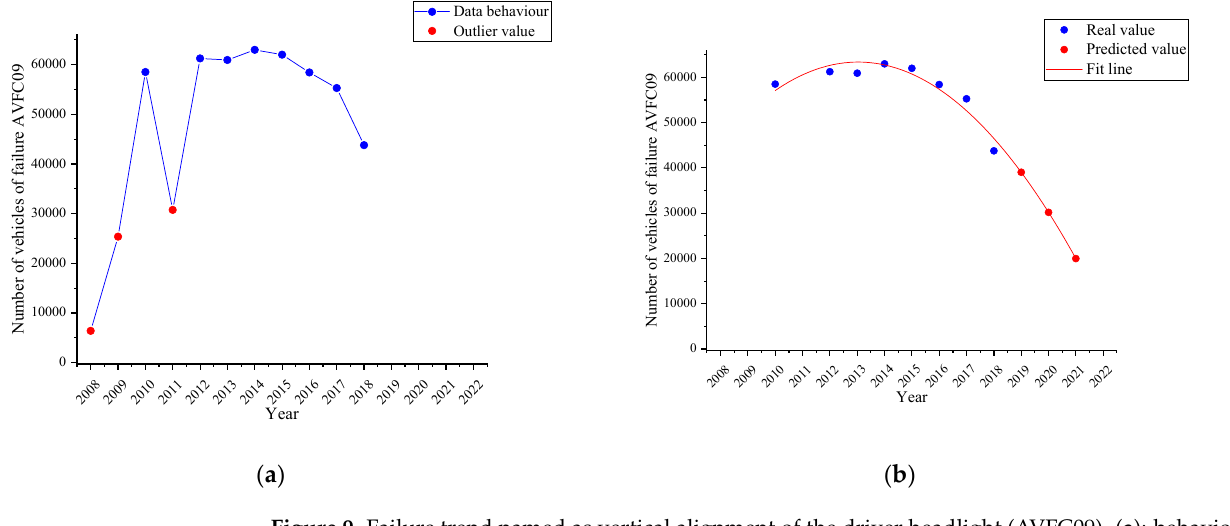
Figure 9. Failure trend named as vertical alignment of the driver headlight (AVFC09). ( a ): behaviour of the failure (blue line); ( b ): the time series with a quadratic trend (red line) and the forecast (red dots).